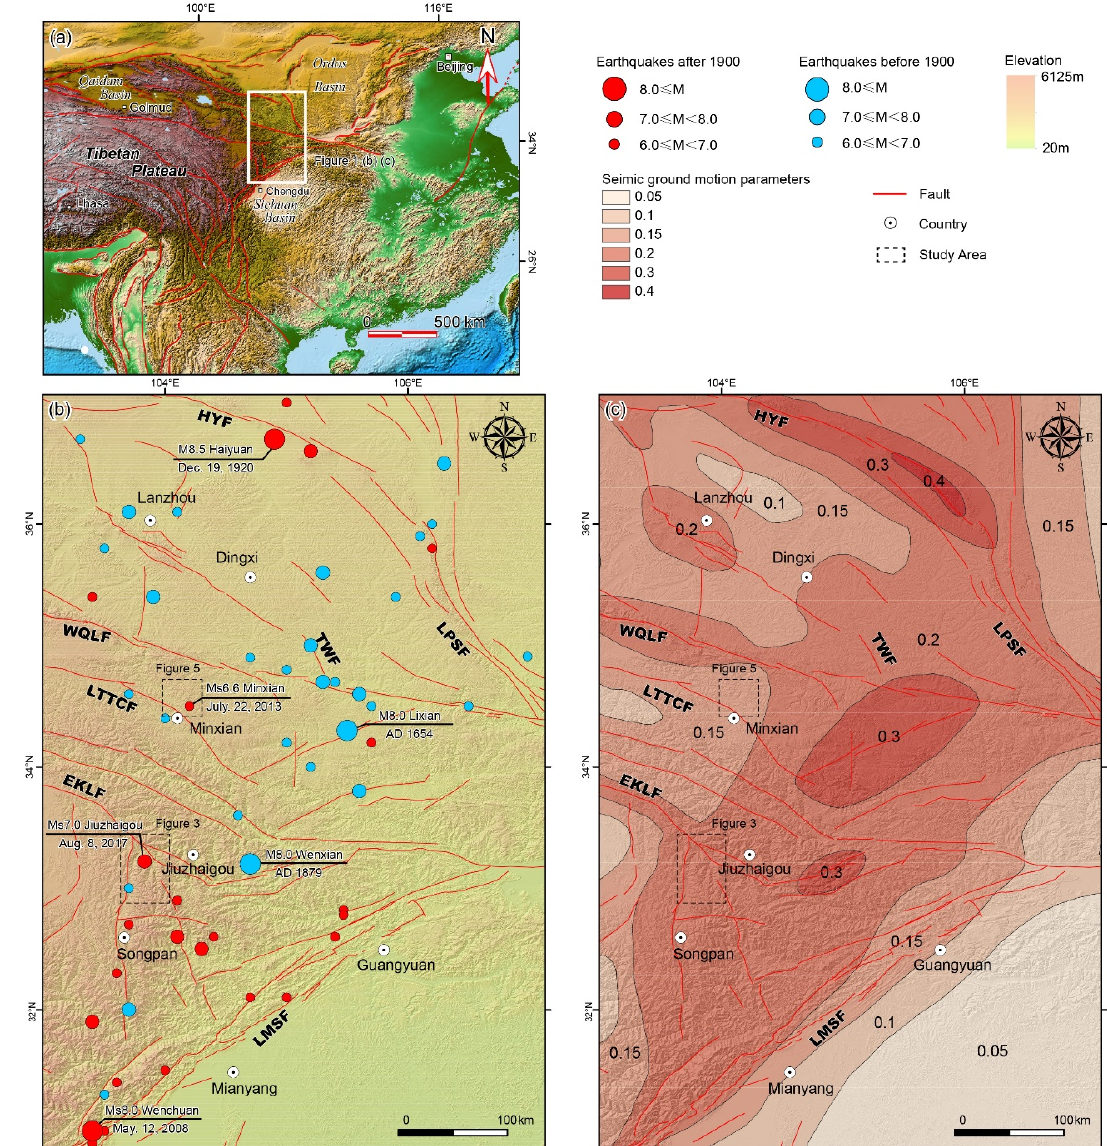
Figure 1. ( a ) The map shows the location of the figure ( b ) and ( c ) in China; ( b ) Active tectonics and large seismic events in the eastern Tibetan Plateau; ( c ) Seismic ground motion parameters zonation map. LMSF: Longmenshan Fault; EKLF: East Kunlun Fault; WQLF: West Qinling Fault; TWF: Tongwei Fault; HYF: Haiyuan Fault; LPSF: Liupanshan Fault; LTTCF: Lintan-Tanchang Fault.